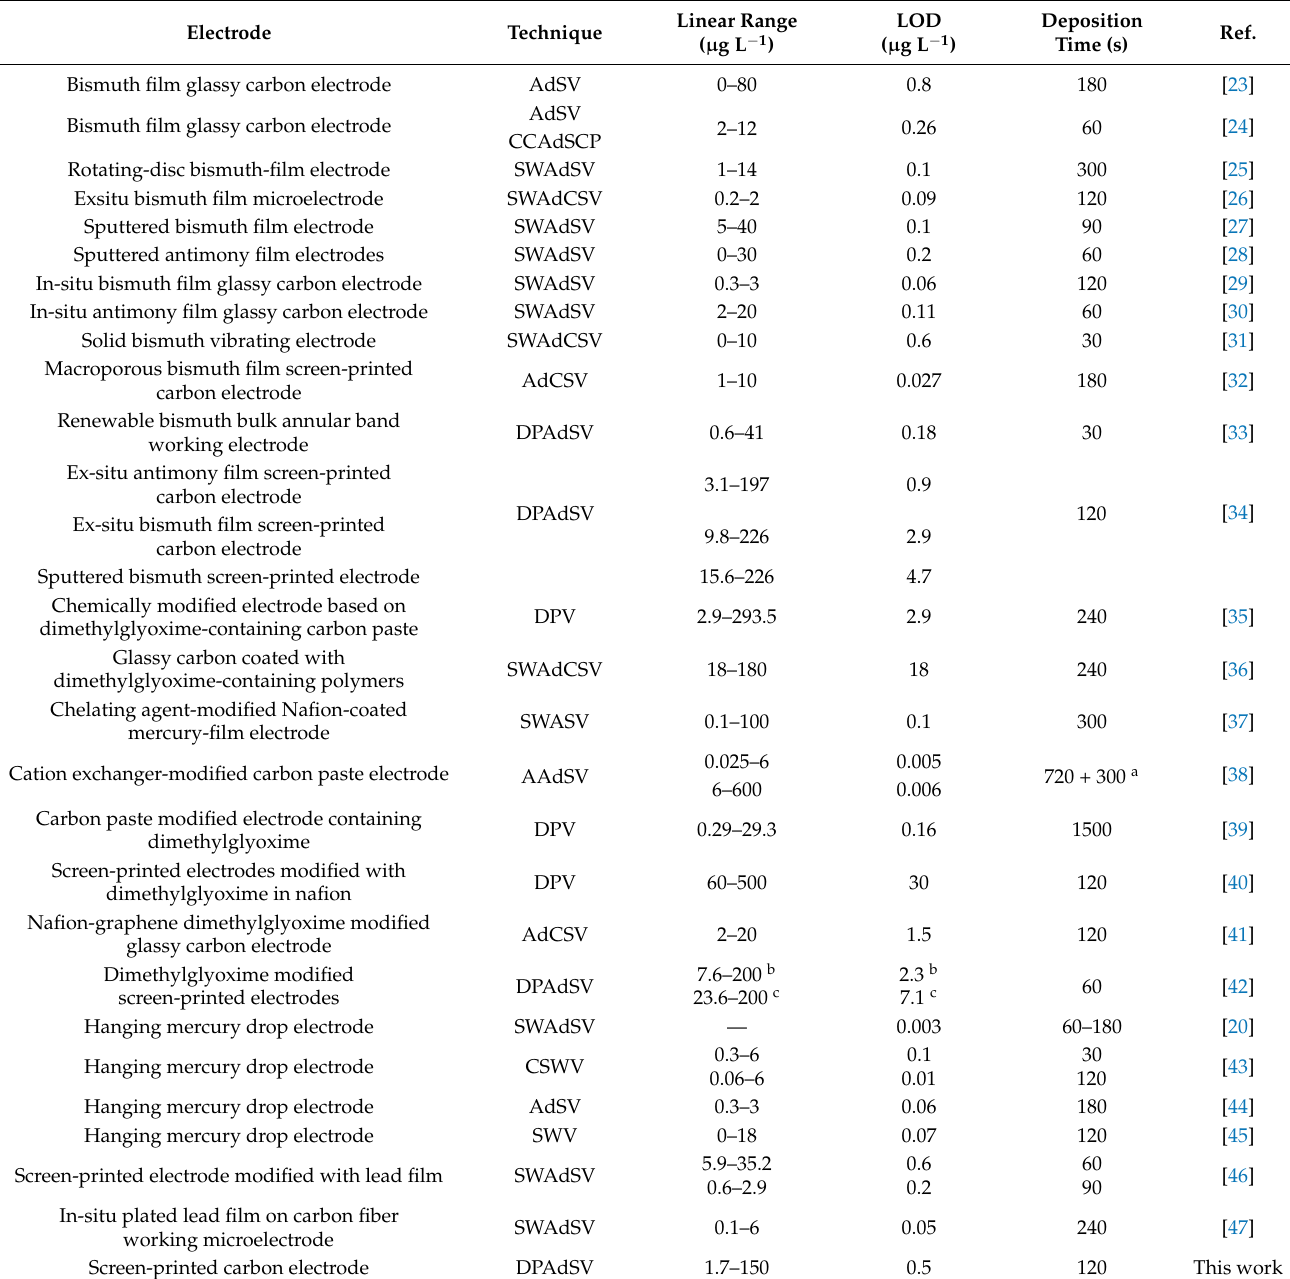
Table 2. Summary of voltametric methods published so far for the determination of